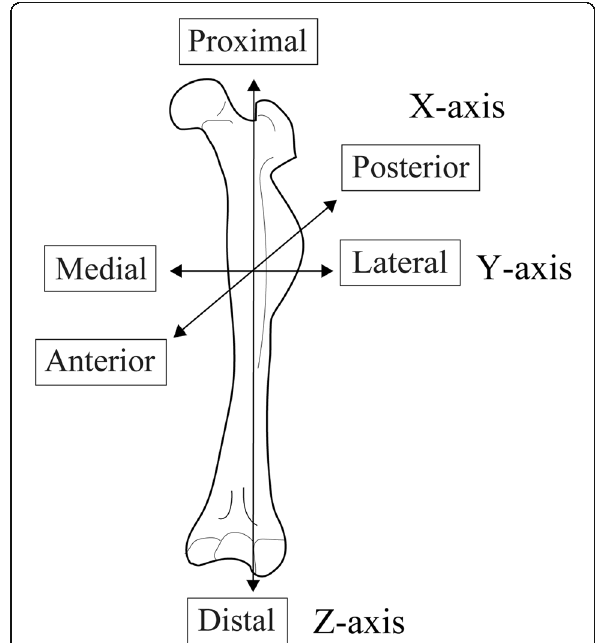
Fig. 3 Femoral coordinate axis. The line connecting the lateral condyle with the greater trochanter of the femur was defined as the long axis of the femur, and the measurement directions of the three axes were set. X axis: anterior-posterior direction, Y axis: mesio-lateral direction, Z axis: femoral long-axis